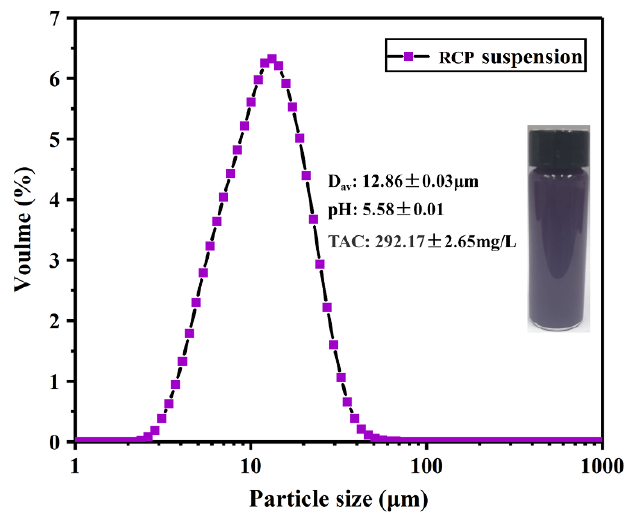
Figure 1. Visual appearance, particle size distribution (PSD), total anthocyanin concentration (TAC), and pH of RCP